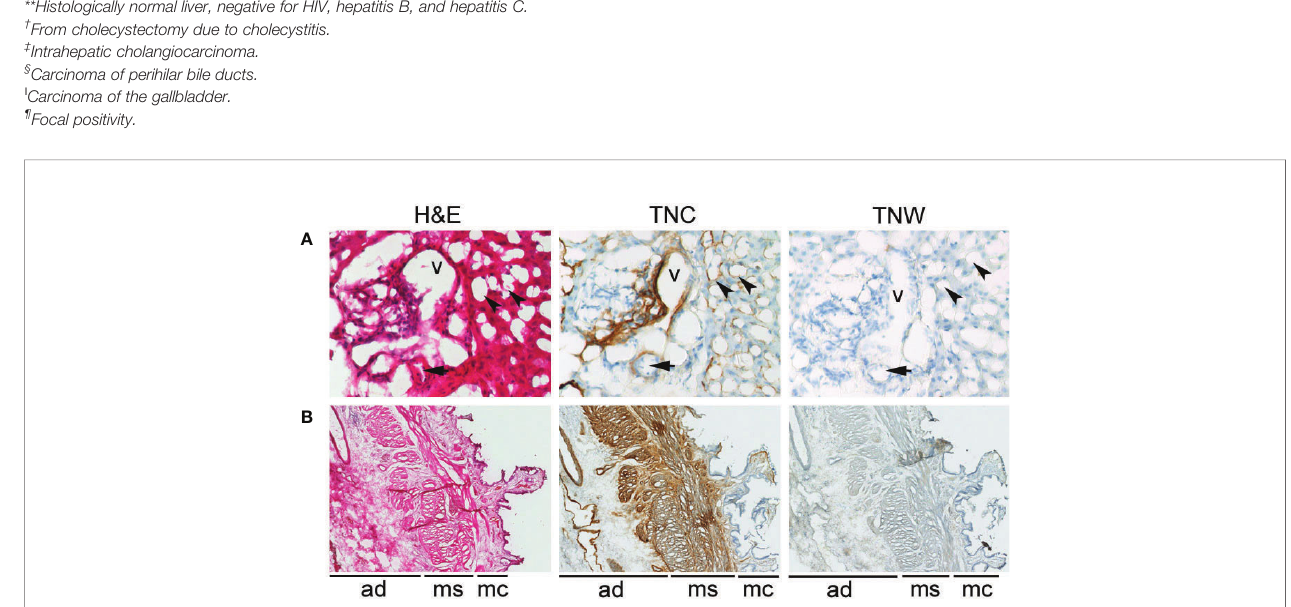
FIGURE 1 | Anti-tenascin-C (TNC) and anti-tenascin-W (TNW) immunohistochemistry of hepatobiliary tissues. (A) TNC immunostaining is observed around sinusoids (arrowheads) and around a vein (v) and an artery (arrow) in portal tract sections of a normal adult liver. An adjacent section is not labeled with TNW immunohistochemistry (400X). (B) TNC immunohistochemistry of a non-tumoral adult gallbladder (cholecystitis) shows labeling around vessels in the adventitia (ad), as well as around bundles of smooth muscle in the muscularis layer (ms). There is also patchy immunoreactivity in the mucosa (mc). In contrast, TNW does not immunolabel gallbladder tissue (40X). A third section in each series was stained with hematoxylin and eosin (H&E).